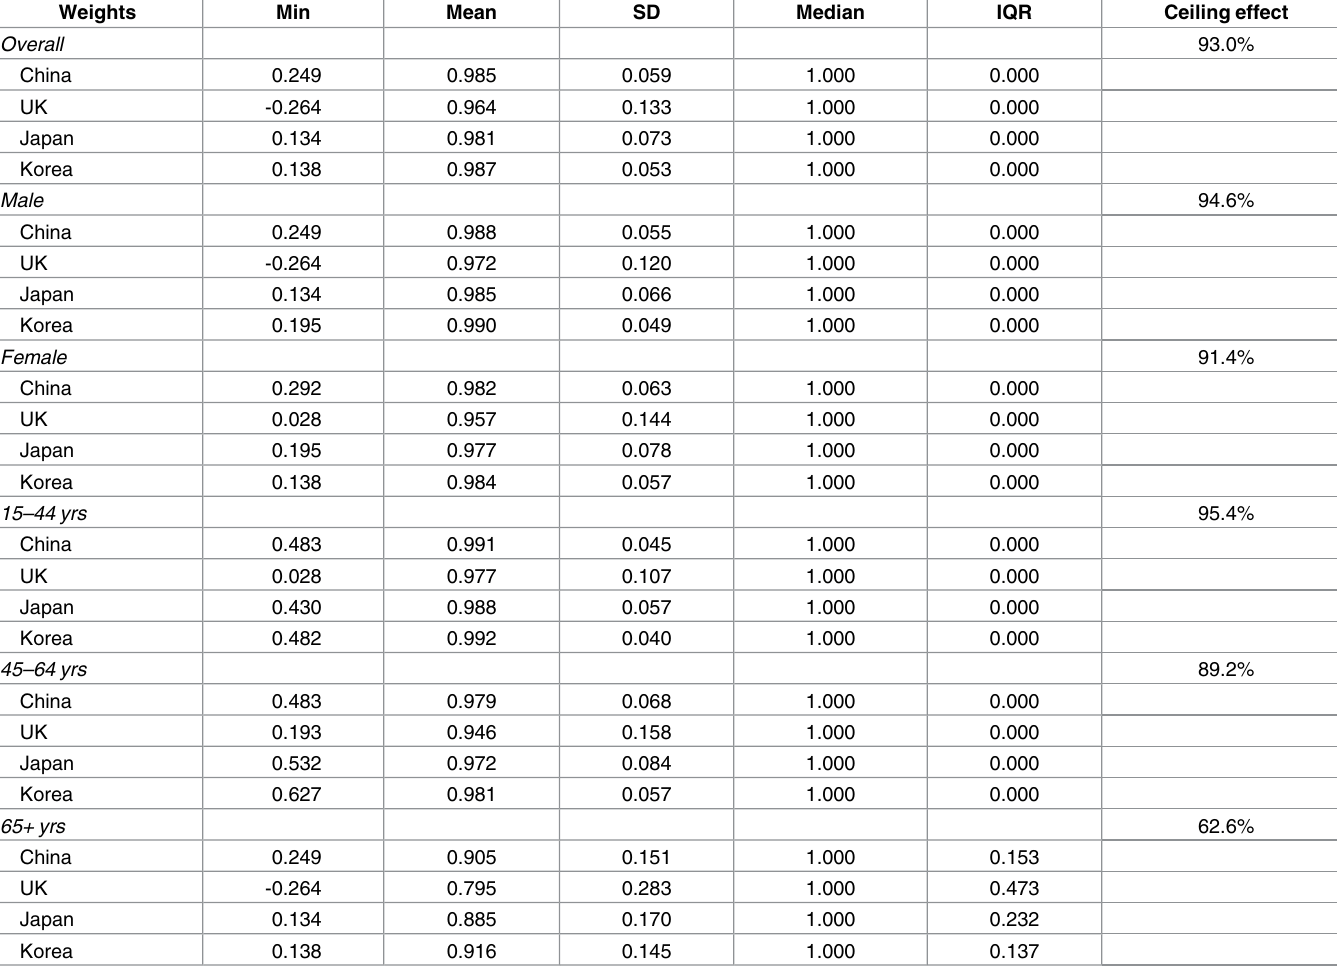
Table 2. Distribution of EQ-5D index scores using China, UK, Japan and Korea weights.